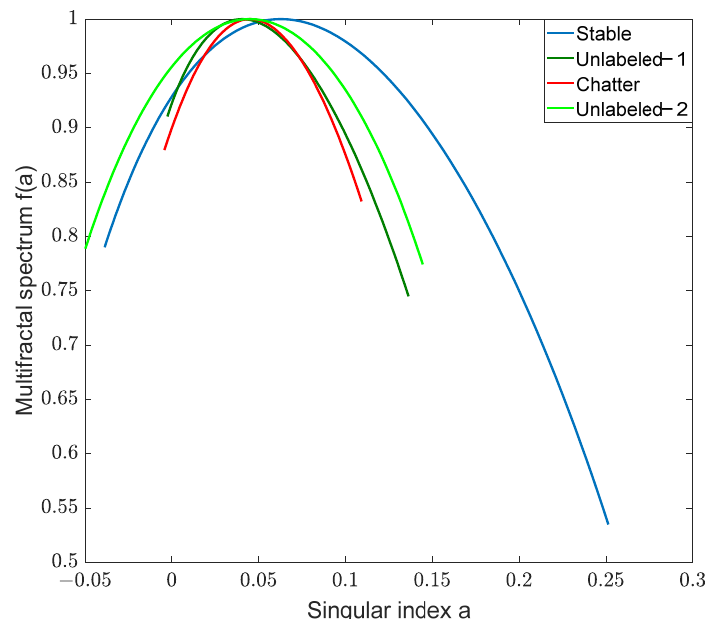
Figure 6. Multifractal spectrum of different chatter states. Table 3. Typical features extracted with MF-DFA.